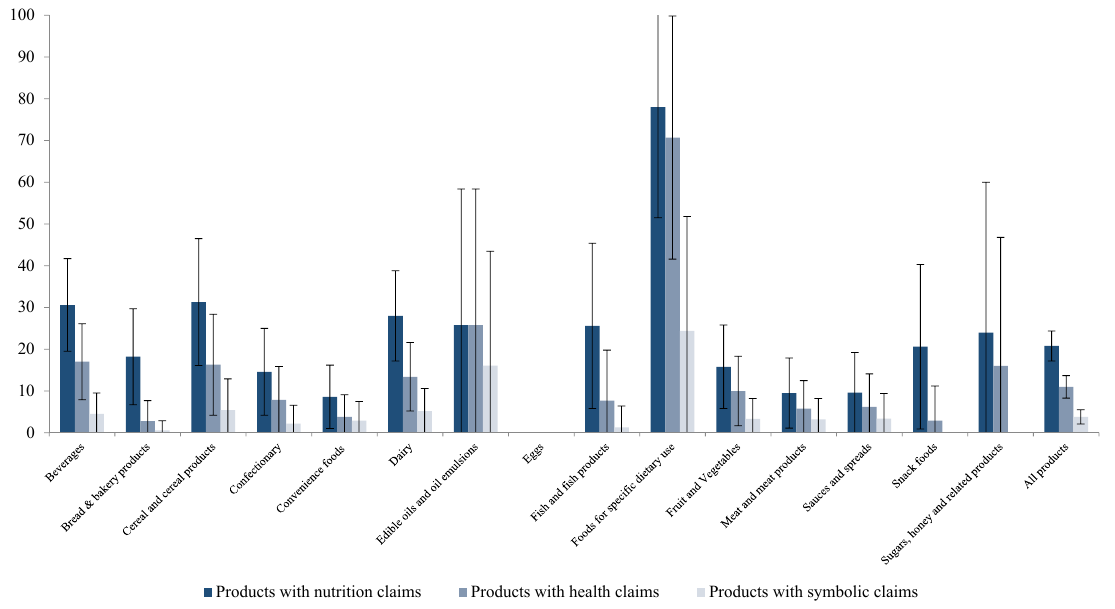
Figure 2. Prevalence of nutrition and health claims (including symbolic ones) by food category. ( Note : % of foods with claim, including the confidence intervals at 95% (see also Supplementary Material Table S1)) .